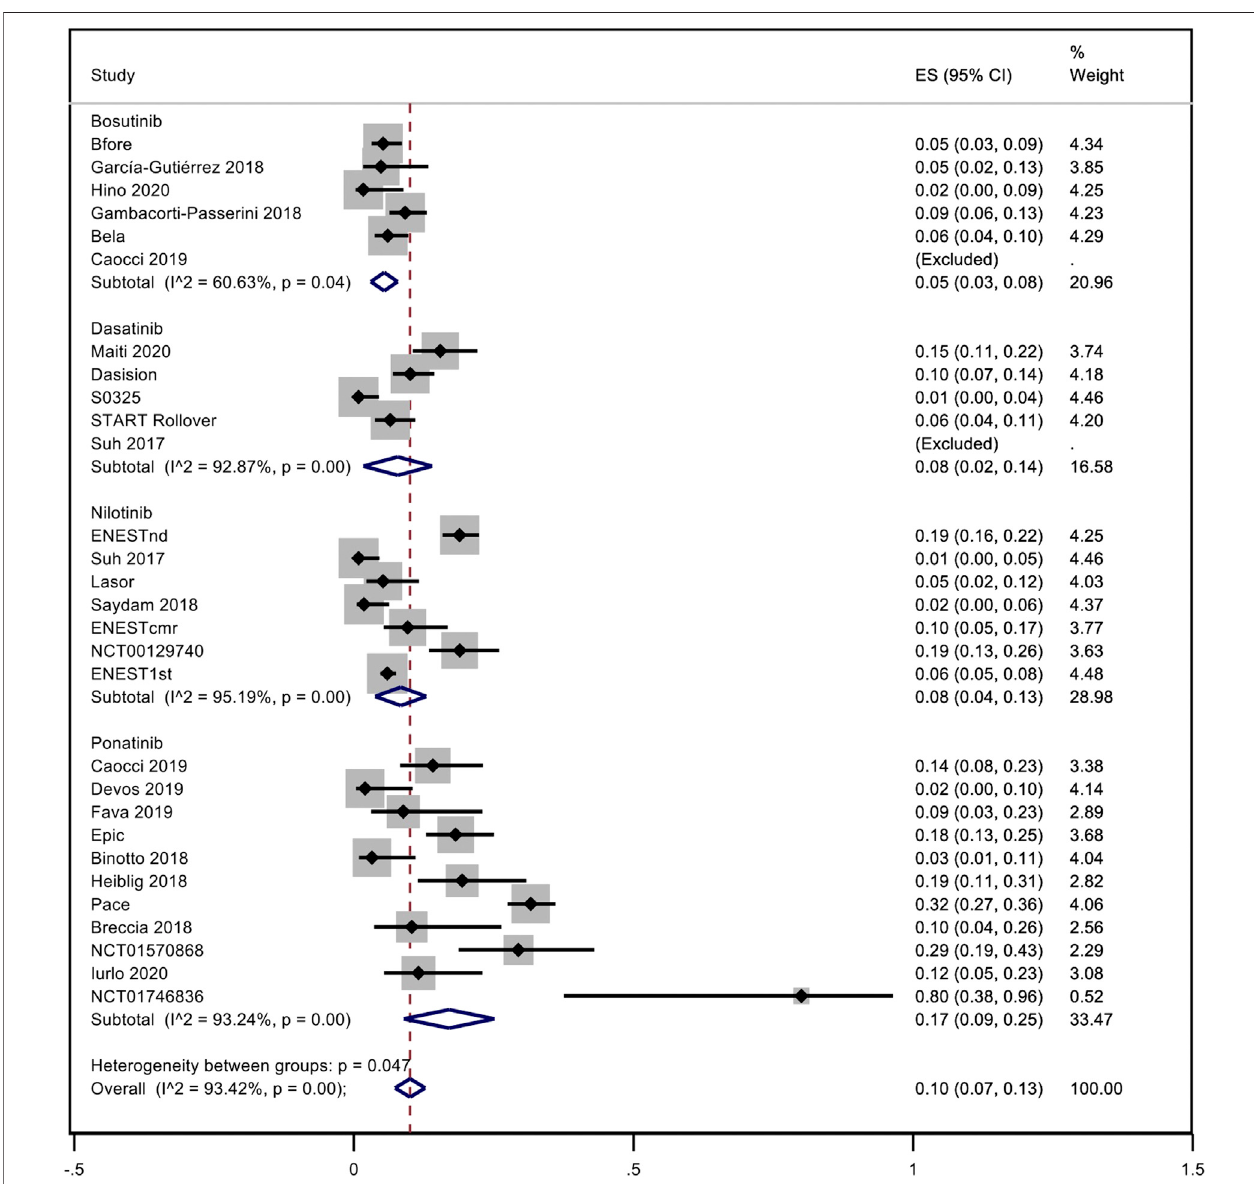
FIGURE 2 | Pooled incidence rate of hypertension in patients treated with second- or third-generation TKI.